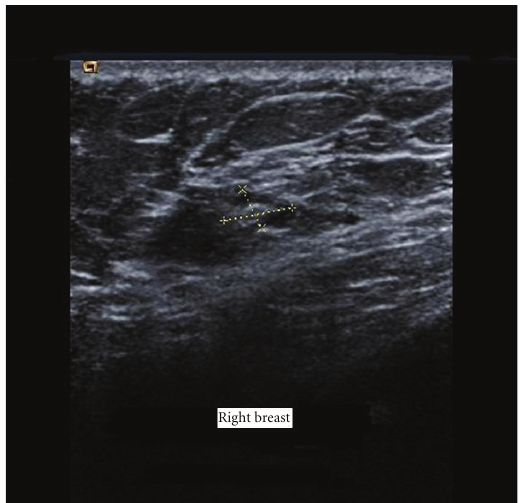
Figure 1: Ultrasonography showed heterogeneous mass with cystic and solid components, measuring 19 × 10 × 11mm.